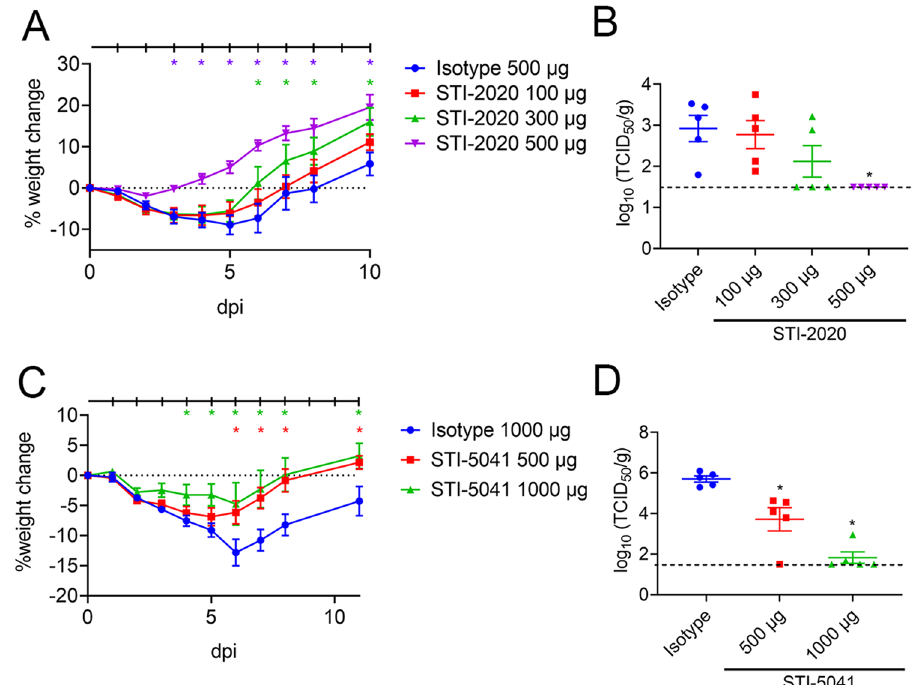
Figure 3. Efficacy of Intravenous (IV) Delivery of Neutralizing Antibodies in the golden (Syrian) Hamster Model of COVID-19. Female hamsters were inoculated with SARS-CoV-2 USA/WA-1/2020 ( A , B ) or SARS- CoV-2 Beta variant ( C , D ) on day 0. One-hour post-infection, animals were administered a single intravenous dose of Isotype control IgG (500 µg) or, For A and B, STI-2020 (100 µg, 300 µg, or 500 µg); For C and D, Isotype control IgG (1,000 µg) or STI-5041 (500 µg, or 1,000 µg). Weight changes were recorded for up to 11 days. ( A ) Average % weight change ± SEM was plotted for each group. Days in which there was a significant difference in average % weight change compared to Isotype control IgG 500 µg-treated animals are denoted by * ( p -value < 0.05). ( B ) Lung tissues collected from five animals per group and virus titers were determined on day 5. A broken line indicates the detection limit of the assay (< 1.5 TCID 50 /g). ( C ) Average % weight change ± SEM was plotted for each group. Days in which there was a significant difference in average % weight change for STI-5041 at 500 µg or 1,000 µg compared to Isotype control IgG 1000 µg-treated animals are denoted by * ( p -value < 0.05). ( D ) Lung tissues collected from five animals per group administered Isotype control